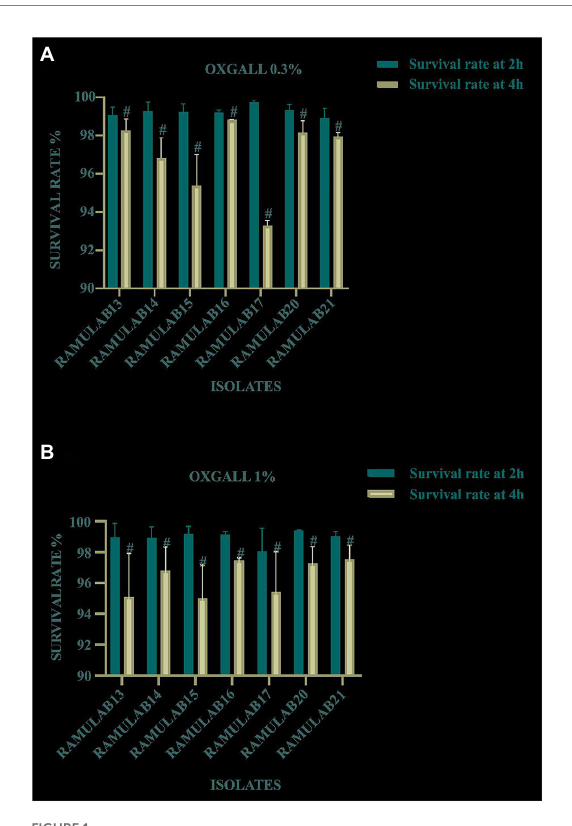
FIGURE 1 Survival of the isolates on MRS agar plates for 2 and 4 h at 37 ° C under circumstances of acidic pH 2 and (A) 0.3% and (B) 1% bile salt concentration. Data are presented as mean ± standard deviation. The Duncan multiple range tests revealed that the means of the survival rate with a 2 h time interval and superscripts (#) are substantially different from one another ( p ≤